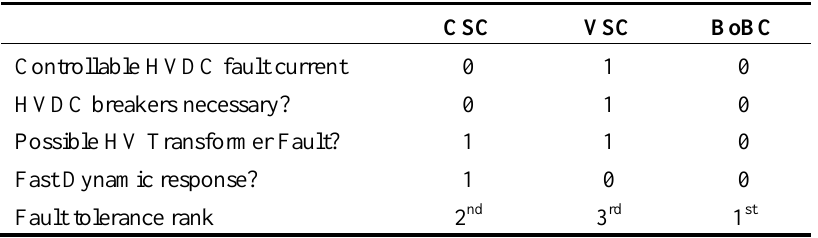
Table 9. Converter fault performance penalty